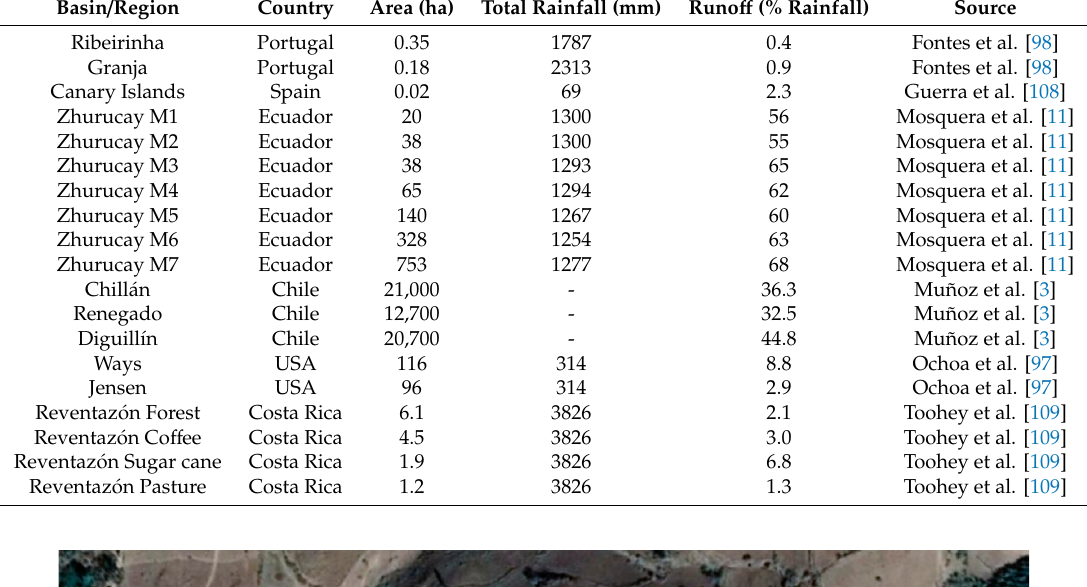
Table A4. Annual runoff coefficients in some watersheds of the world. Basin/Region Country